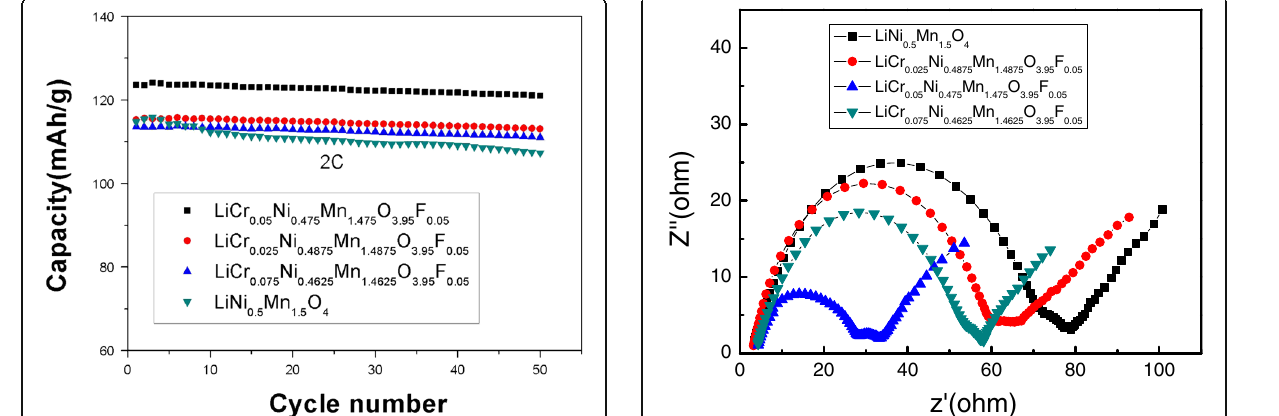
Fig. 9 EIS patterns of LiNi 0.5 Mn 1.5 O 4 and LiCr x Ni 0.5 − 0.5x Mn